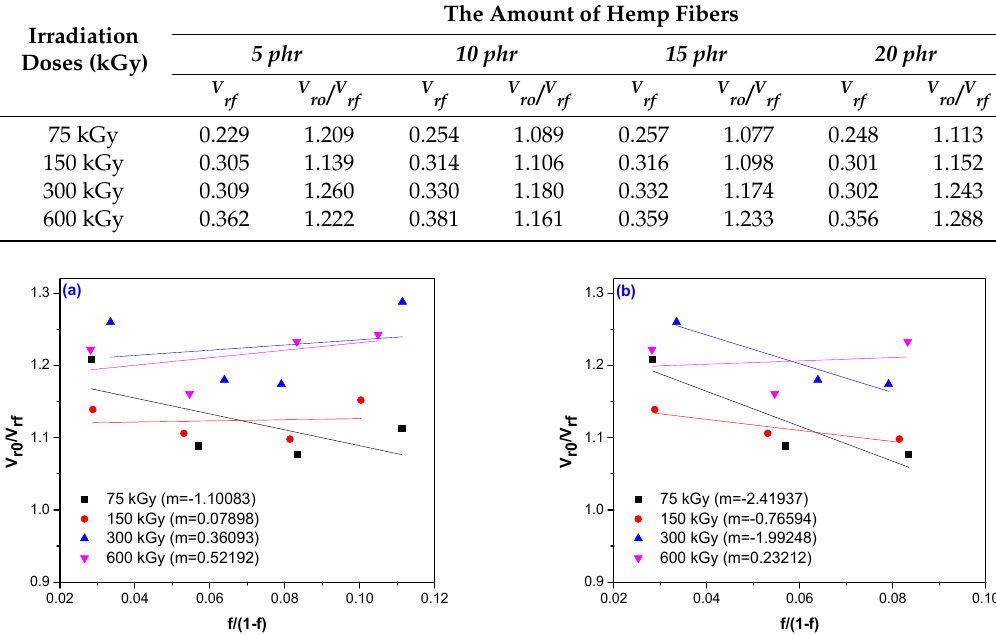
Figure 10. Graphical representation of the Kraus equation for EPDM / hemp fiber composites at di ff erent irradiation doses in order to determine the values of parameter ‘ m ’ for: ( a ) mixtures with 5, 10, 15 and 20 phr hemp and ( b ) for mixtures with 5, 10 and 15 phr hemp.